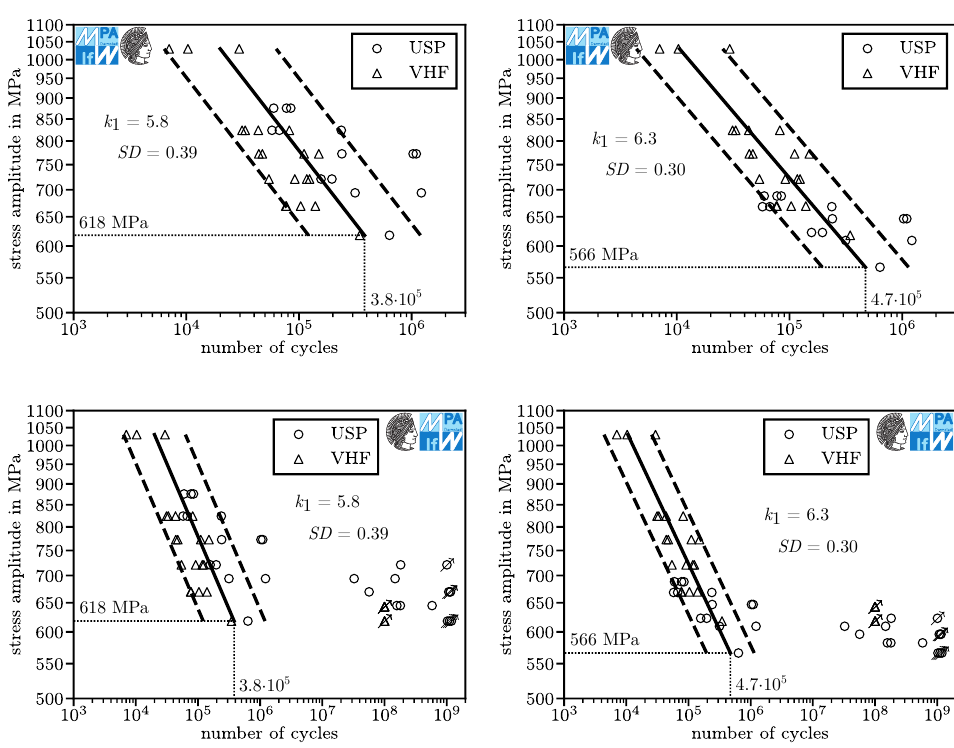
Figure 11. Fatigue behavior of 50CrMo4 in laboratory air; 919 MPa ultimate tensile strength; K t = 2.06; run-outs are marked with an arrow; left side: before correction; right side: after correction; top: only HCF region; bottom: including VHCF